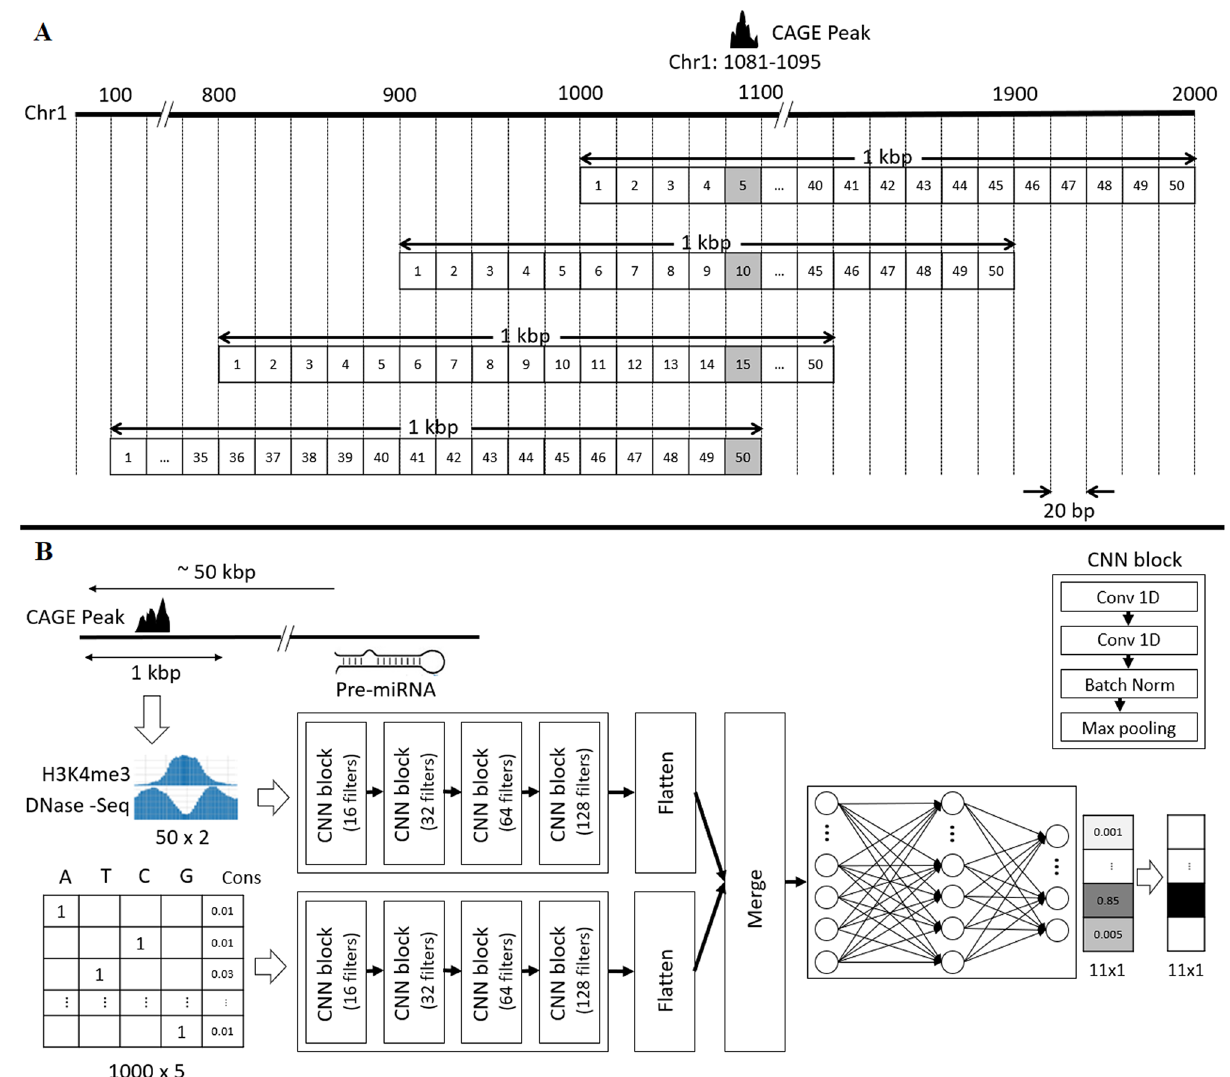
Figure 1. The D-miRT architecture. (A) The input matrix for the first CNN component and the output labels of D-miRT are created by sliding and binning the 1 kbp region around a CAGE peak. The bin number containing the TSS peak is used as training label for an input positive sample. (B) Two separate CNN components for activation marker and sequence inputs, each one having 4 CNN blocks. The features learned by the two components are merged and fed through a three-layer fully connected neural network that outputs the probability of a TSS to be within a certain TSS-containing width cannot be more than 10 bp and the bin size is 20 bp, every TSS peak resided in only one of the 50 bins (Fig. 1A). In order to train the model about the location of the TSS in the input region, for every TSS peak, 10 input samples were generated by sliding the 1 kbp region by 100 bp (5 bins) each time for 10 times. The 10 input samples (positive samples) are 1 kbp regions having the TSS peak in 10 different bins (Fig. 1A). In order to train the model about the input regions with no TSS, a 1 kbp flanking region of the TSS peak that did not contain any TSS peak was also included (negative samples). The output of the model is an 11 × 1 vector. The row numbers 0 to 10, correspond to the probabilities that a region is from the negatives or each of the 10 types of positives (Fig. 1B). Representation of the input and output in such a way enables the model to answer both the questions “is there a TSS?” and “where is the TSS?”. In order to predict a TSS within a region, D-miRT considers both the H3K4me3 and DNase-Seq profiles and the sequence features within the region. For every sample, a 50 × 2 matrix is generated with the DNase-Seq and the H3K4me3 peak coverages in the 50 bins of the corresponding input region. As to the sequence fea- tures, the one-hot encoding of the sequence and its conservation score of every genomic location within the 1 kbp TSS-containing region were used to create a 1000 × 5 input matrix. The one-hot encoding is a 1 × 4 vector representation of a nucleotide ([1 0 0 0] for A, [0 1 0 0] for T, [0 0 1 0] for C and [0 0 0 1] for G). After binning and shifting the TSS-containing regions 10 times and including the negative regions without TSS, the number of samples generated for the seven cell lines A549, GM12878, HeLa-S3, HepG2, hESC, K562 and MCF-7 are